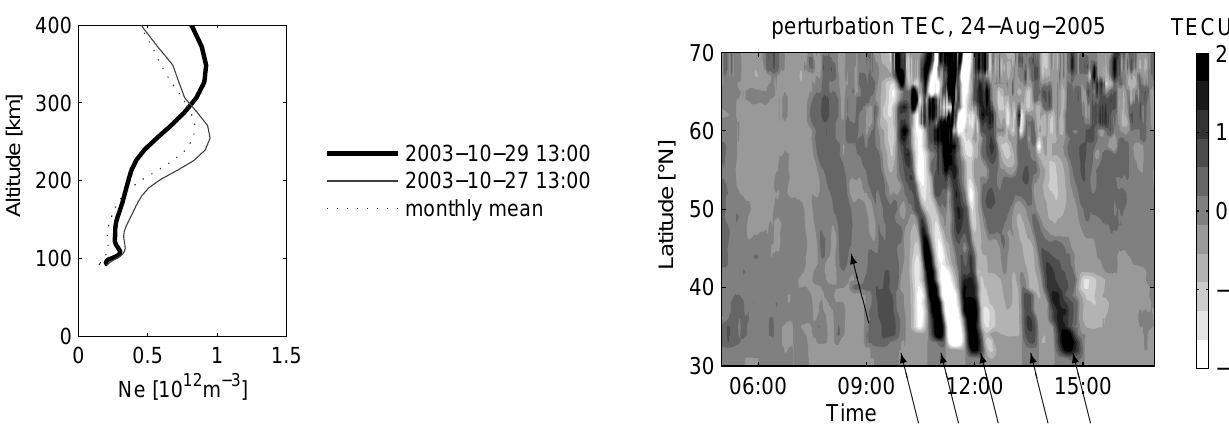
Fig. 7. Time-Latitude-Plot of TEC perturbations for the 24 August 2005 05:00–18:00UT at 12 ◦ E. The arrows indicate the wave fronts of the